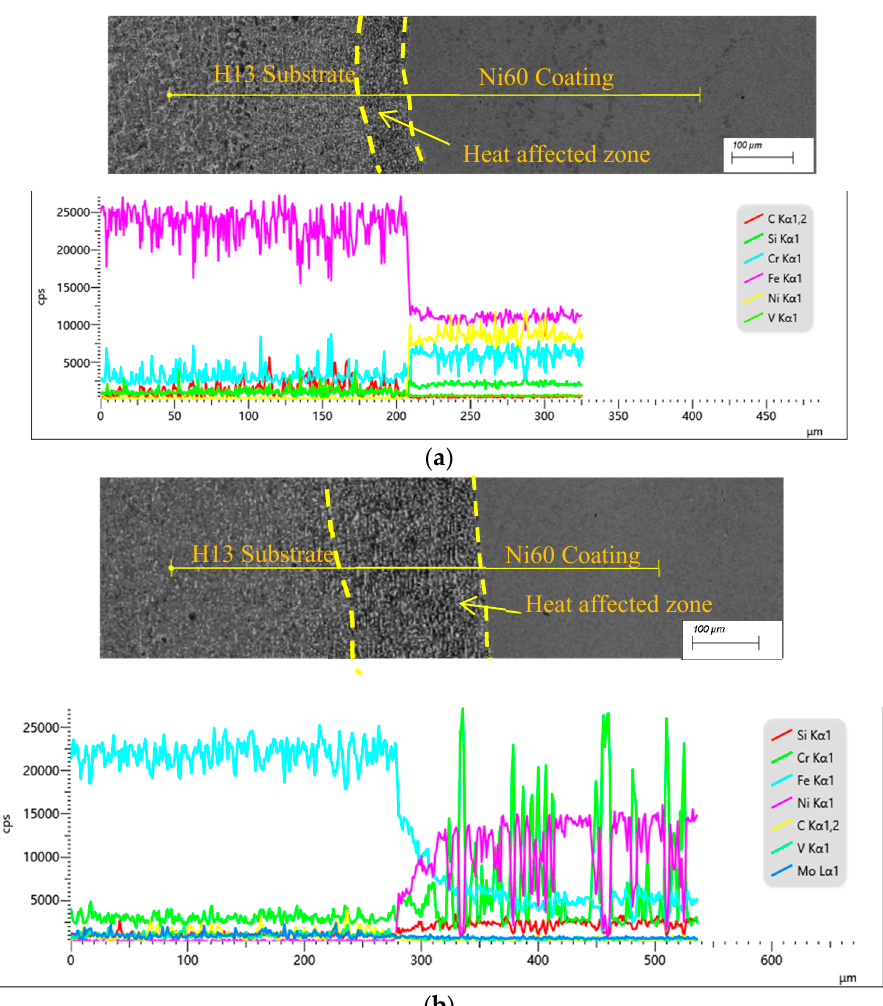
Figure 6. Line scan result of cladding layer metallurgical bond zone. ( a ) No ultrasonic vibration; ( b ) 34kHz ultrasonic vibration.